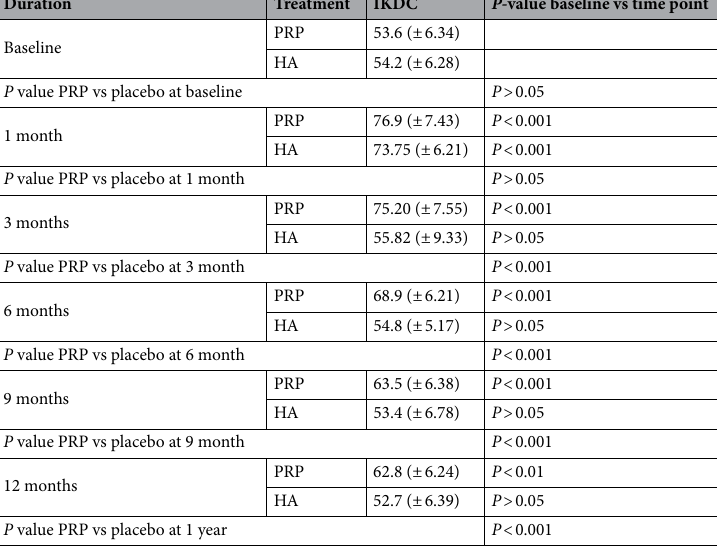
Table 3. IKDC scores of patients in PRP and HA groups over 1 Year. DC International Knee Documentation Committee, PRP platelet-rich plasma, HA Hyaluronic acid.